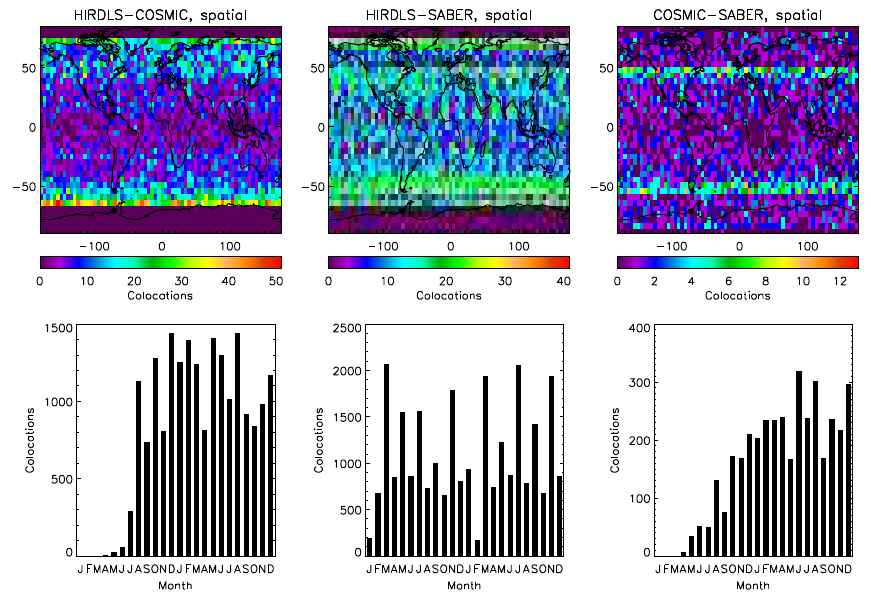
Fig. 1. Details of the temporal and spatial distributions of profile-pairs between each pair of instruments (from left: HIRDLS-COSMIC, HIRDLS-SABER, COSMIC-SABER). In each case, the upper plot shows the geographic distribution of pairs, and the lower plot the temporal distribution.